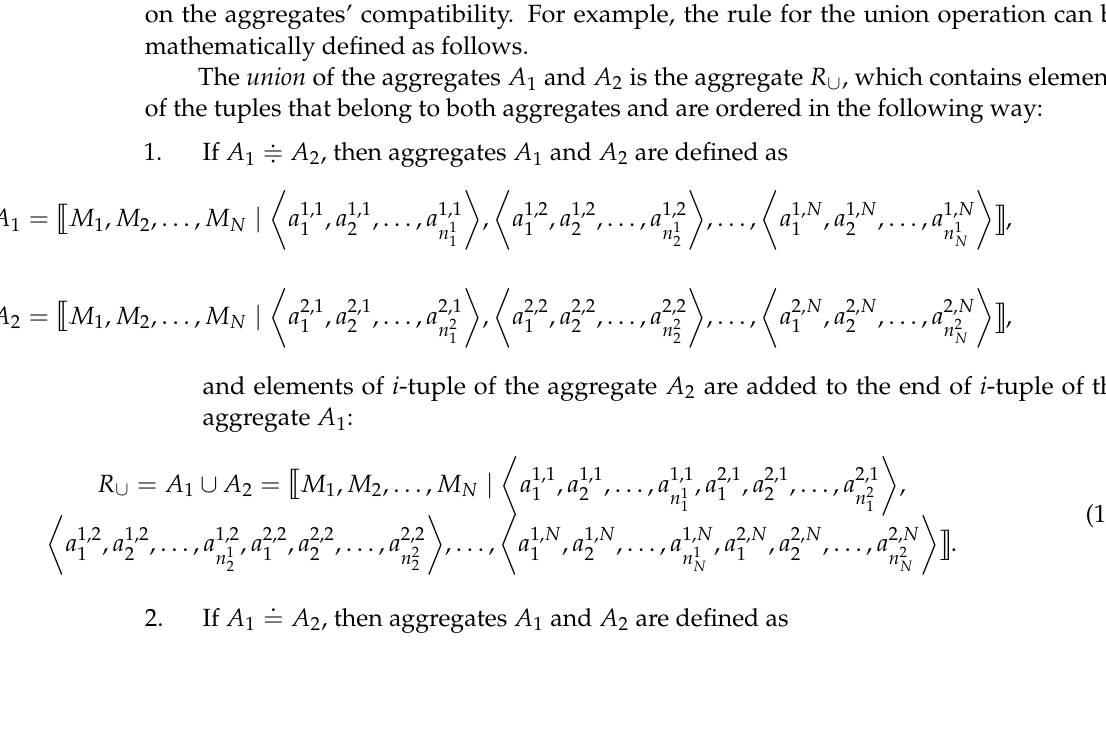
Figure 1. An example of two compatible aggregates. Figure 4. An example of two hiddenly compatible